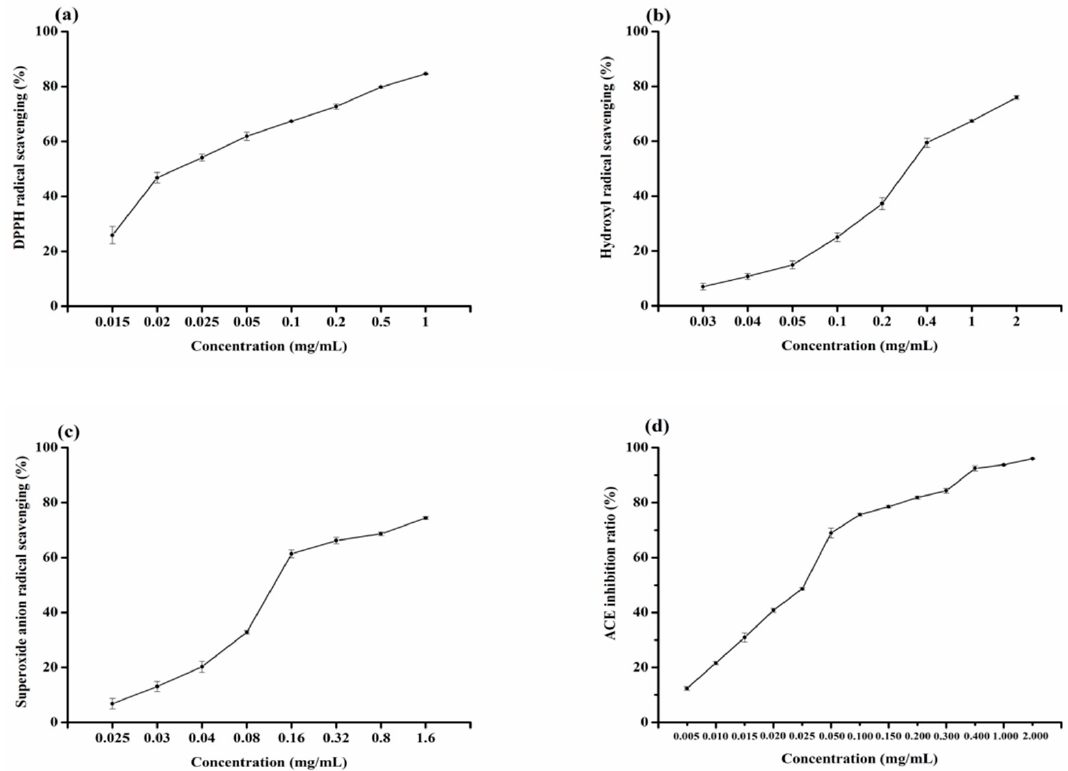
Figure 5. ( a ) DPPH radical scavenging activity of Ser-Tyr. ( b ) Hydroxyl radical scavenging activity of Ser-Tyr. ( c ) Superoxide anion radical scavenging activity of Ser-Tyr. ( d ) ACE inhibitory activity of Ser-Tyr.